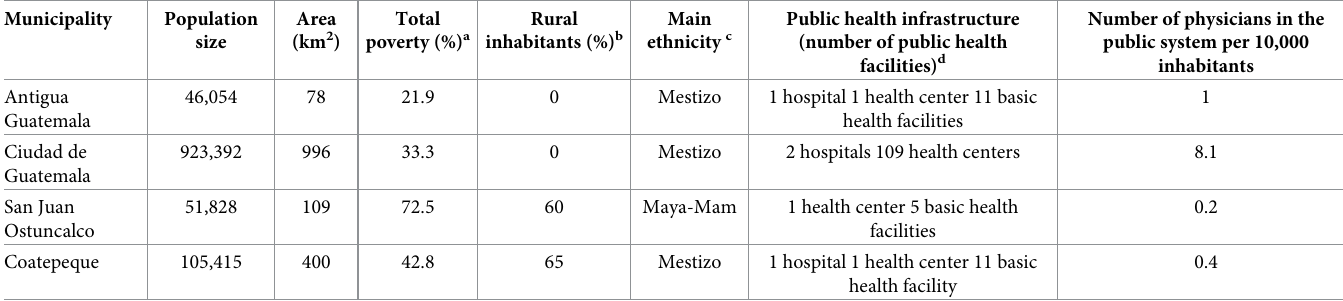
Table 1. Characteristics of the study municipalities [6,